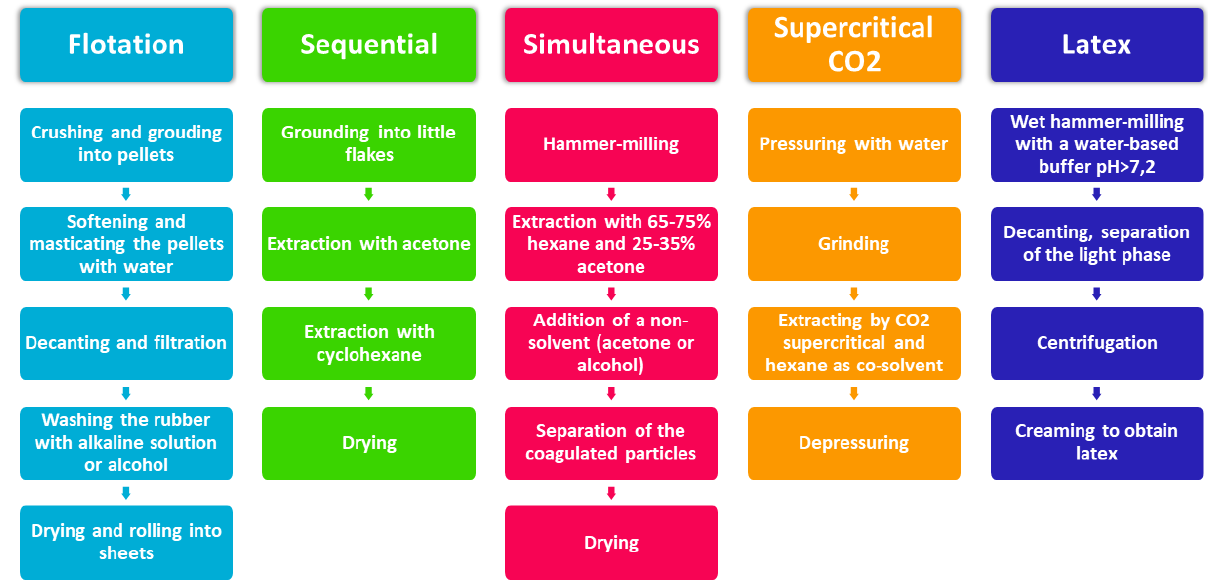
Figure 9. Industrial processes to extract rubber and latex from guayule plants.